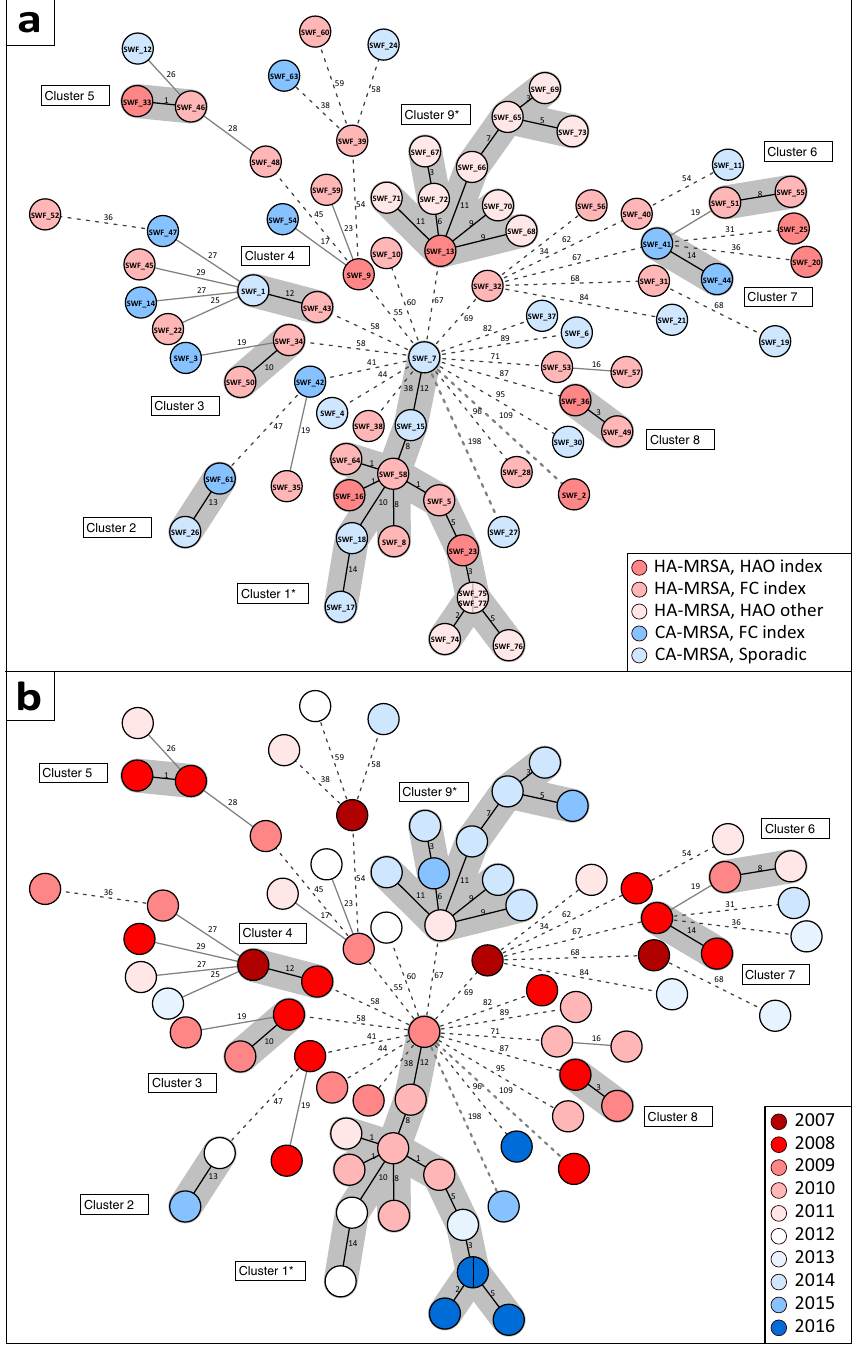
Figure 3. (a) Minimum spanning tree based on single nucleotide variants (SNVs) between the core-genome alleles of 75 spa t172 MRSA isolates, Hospital District of Southwest Finland, years 2007–2016. Each node represents one or two isolates as stated in the node. 62 isolates represent index cases from healthcare-associated outbreaks (HAO, n = 9) and family clusters (FC, n = 37) and sporadic cases (n = 16). The rest, 13 isolates, are from other additional HAO cases acquired via clinical HAO investigations. Clusters are highlighted with grey background, distance threshold 15 SNVs. Epidemiological case data shown by the colour scheme as stated in the figure legends: blue indicates community (CA-MRSA) origin, with additional parameters: dark blue family cluster (FC) index case and light blue sporadic case. Red indicates healthcare (HA-MRSA) origin: dark red HAO index case and, light red FC index case and pale red other HAO case. ( b) Isolate detection year shown by the colour scheme. *Clusters including isolates from clinical HAO investigations (legend: HAO other) marked with